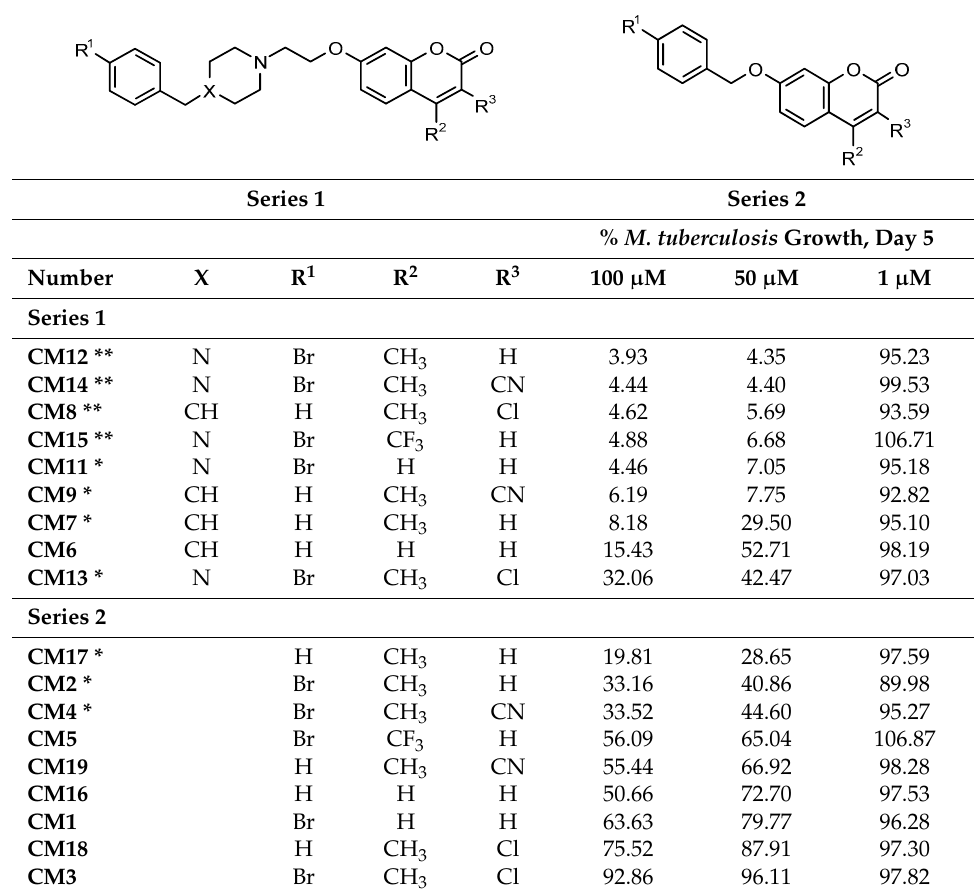
Table 1. Molecular structure and activity of coumarin derivatives series 1 and 2.